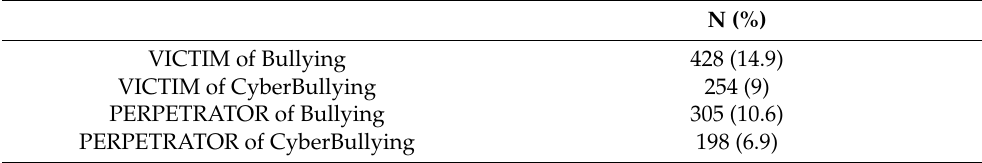
Table 1. Rates of bullying and cyberbullying self-reported by UPRIGHT